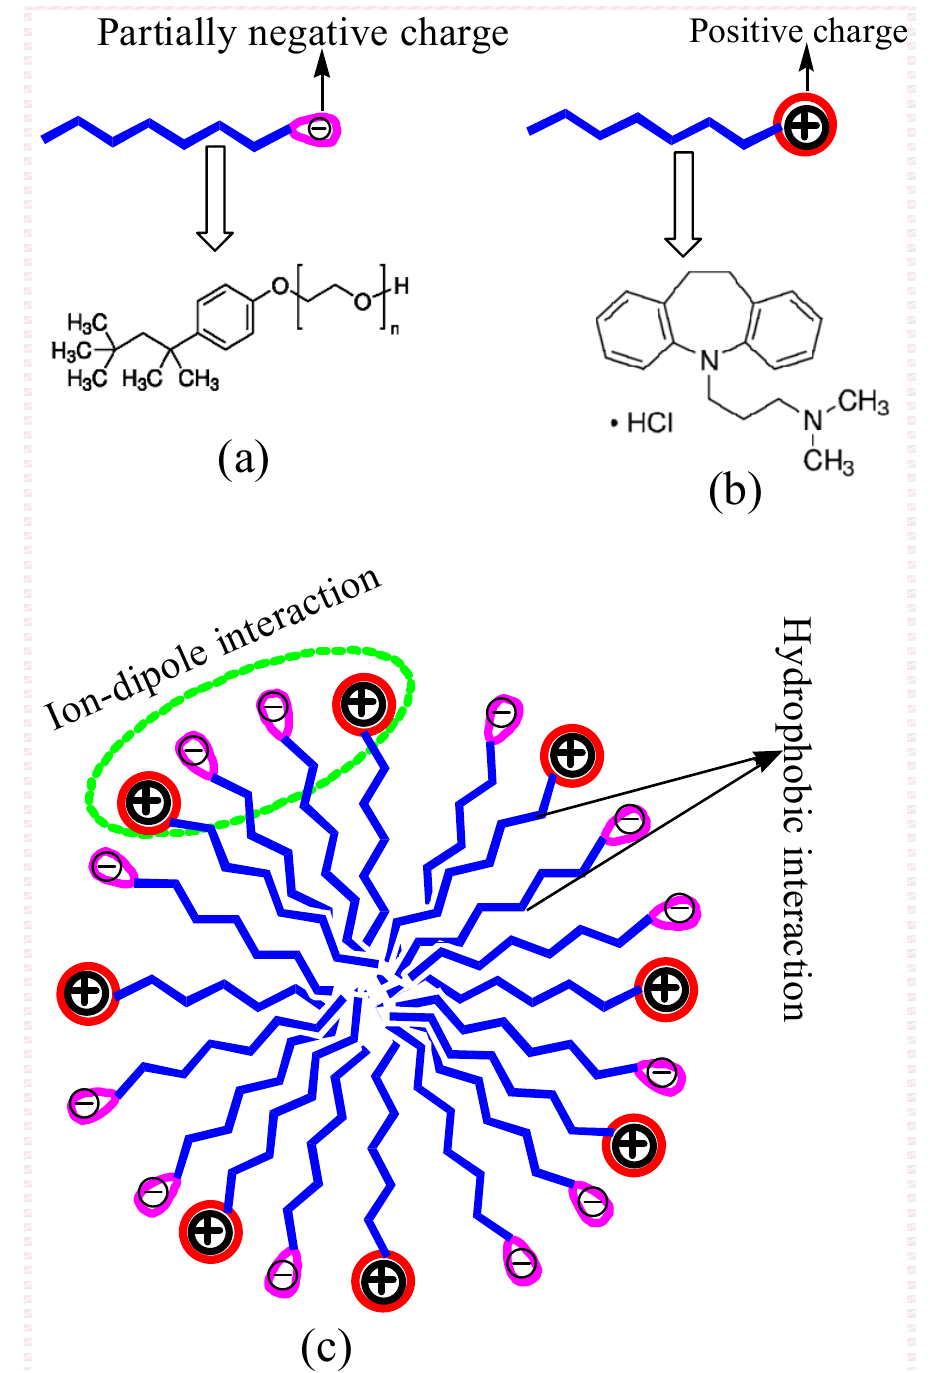
Figure 1. Molecular structure of ( a ) TX-100 ( n = 9–10), ( b ) imipramine hydrochloride (IMP), and ( c ) their interaction in mixed